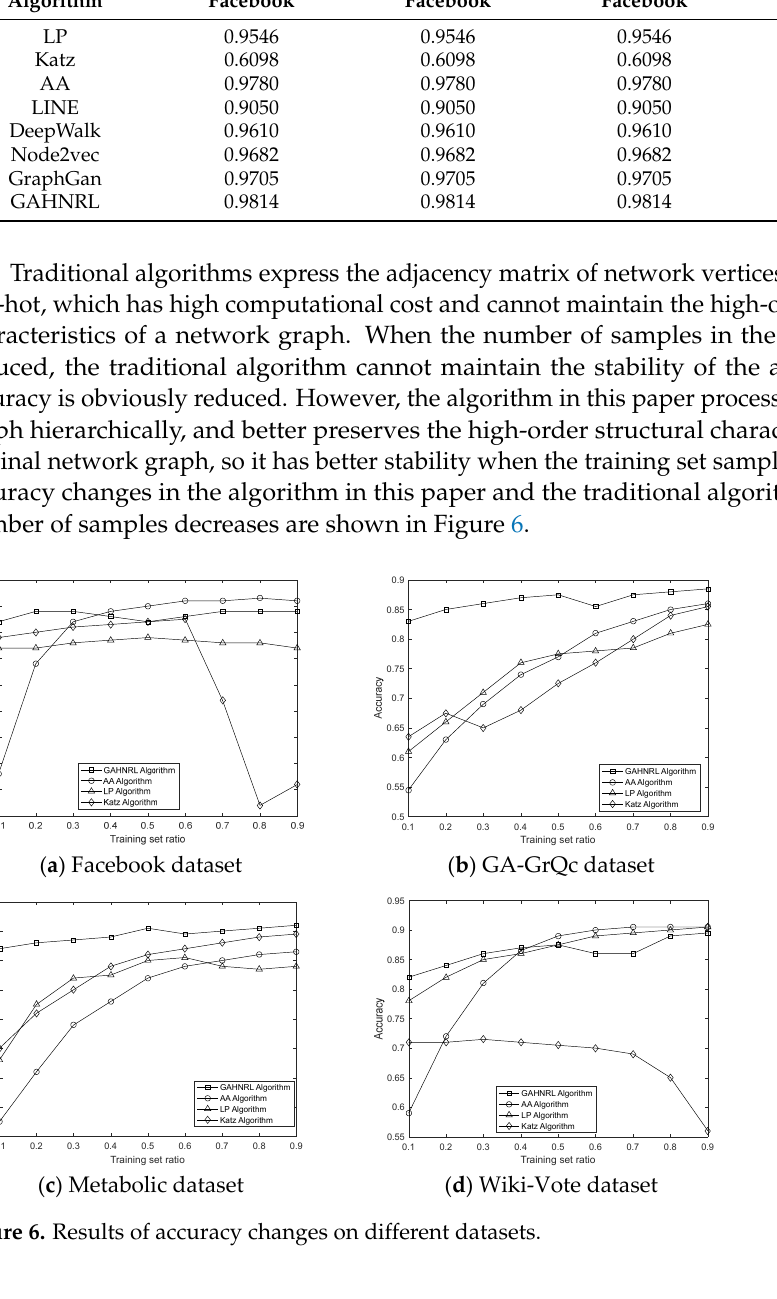
Figure 6. Results of accuracy changes on different datasets.